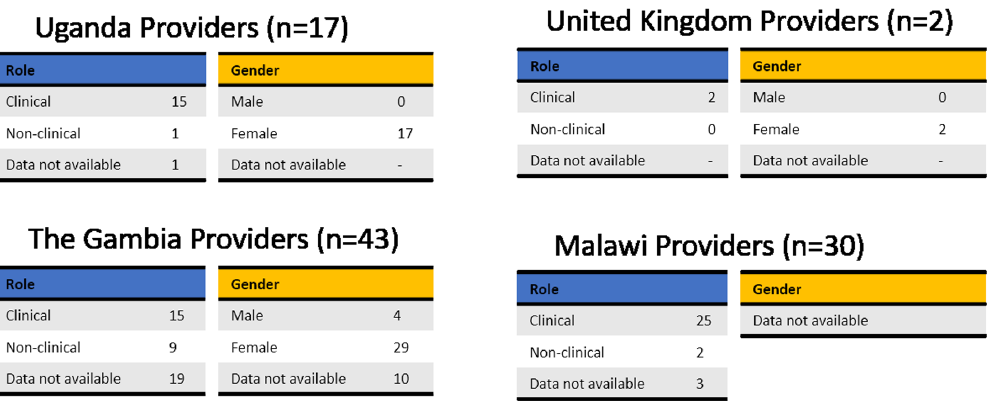
Figure 5. Demographic data of providers grouped by country. Potential providers with a range of roles took part in this study. Tables are based on the available data only, as not all participants completed the